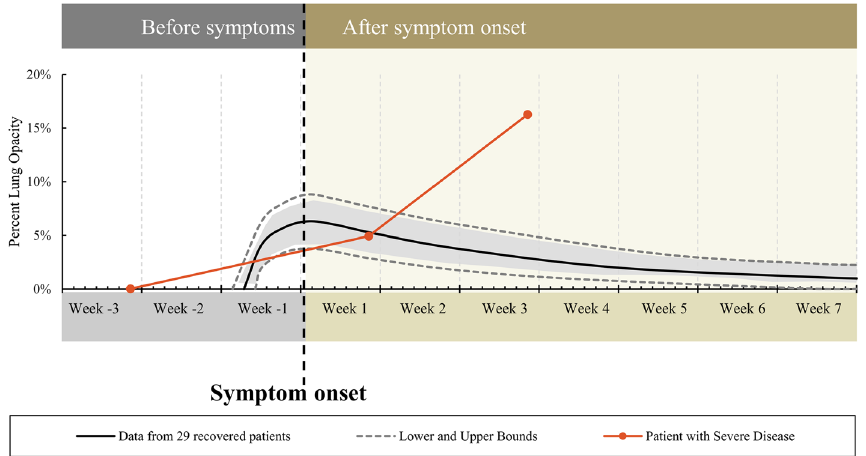
Figure 6. Demonstration of the utility of the dynamic curve using a pre-selected patient with severe COVID- 19. Percent lung opacity was calculated from 3 serial chest CT’s. Deviation from the mild to moderate disease curve occurs 9 days after symptom onset, as a clinical "red